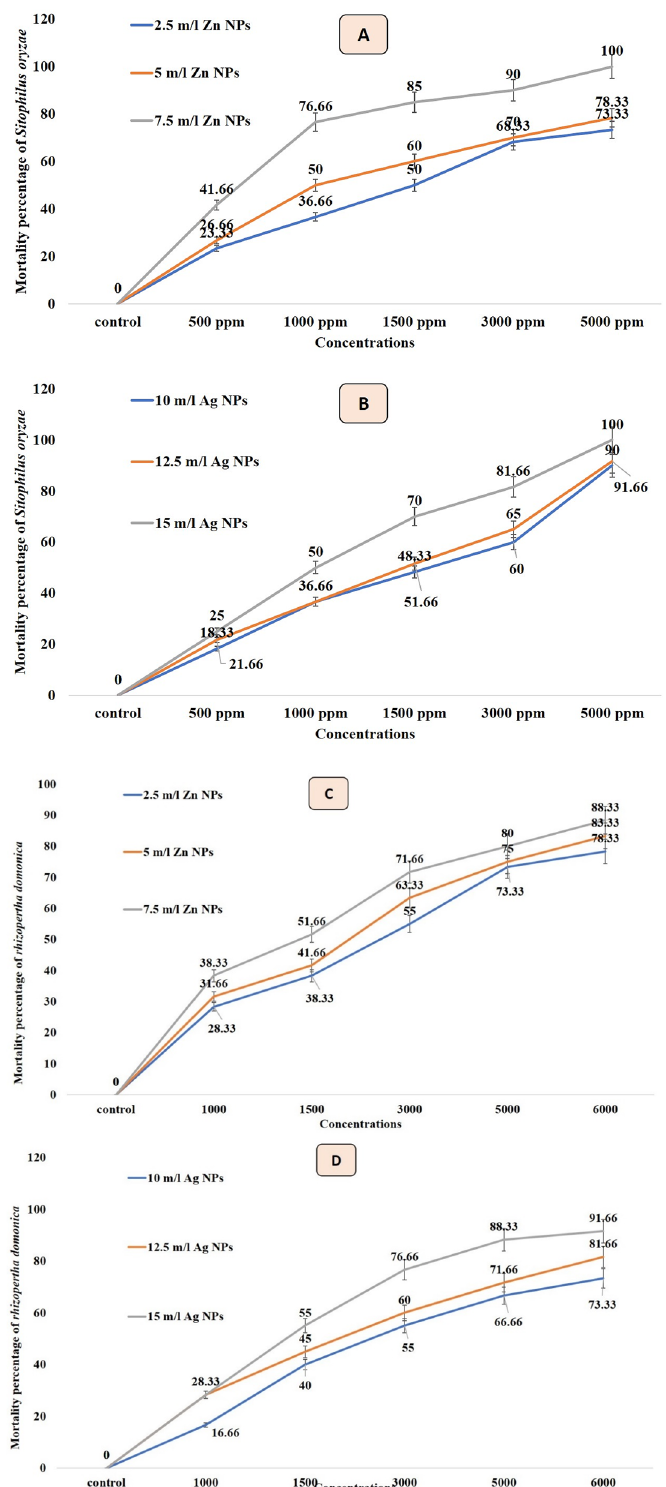
Figure 2. ( A ) Effect of acetone extracts from leaves of trees treated Zn NPs (a) and Ag NPs (b) on mortality percentage of Sitophilus oryzae . ( B ) Effect of acetone extracts from leaves of trees treated Zn NPs (c) and Ag NPs (d) on mortality percentage of Rhizopertha